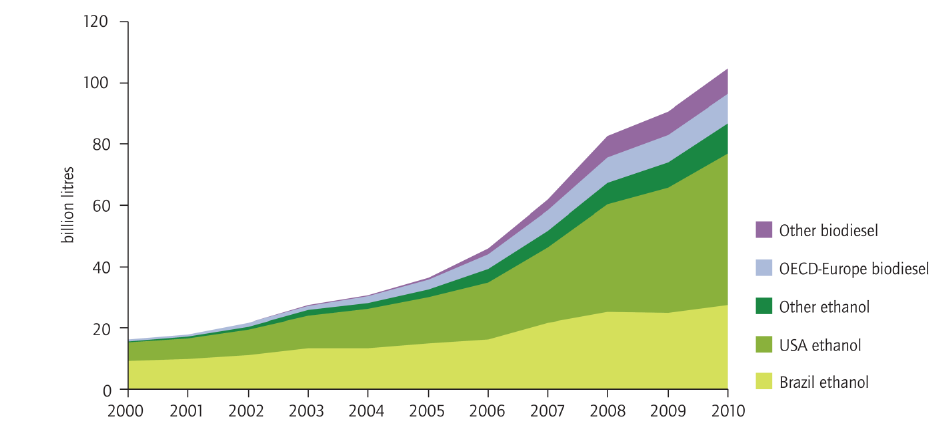
Fig. 6. World production of biofuel from 2000–2010.